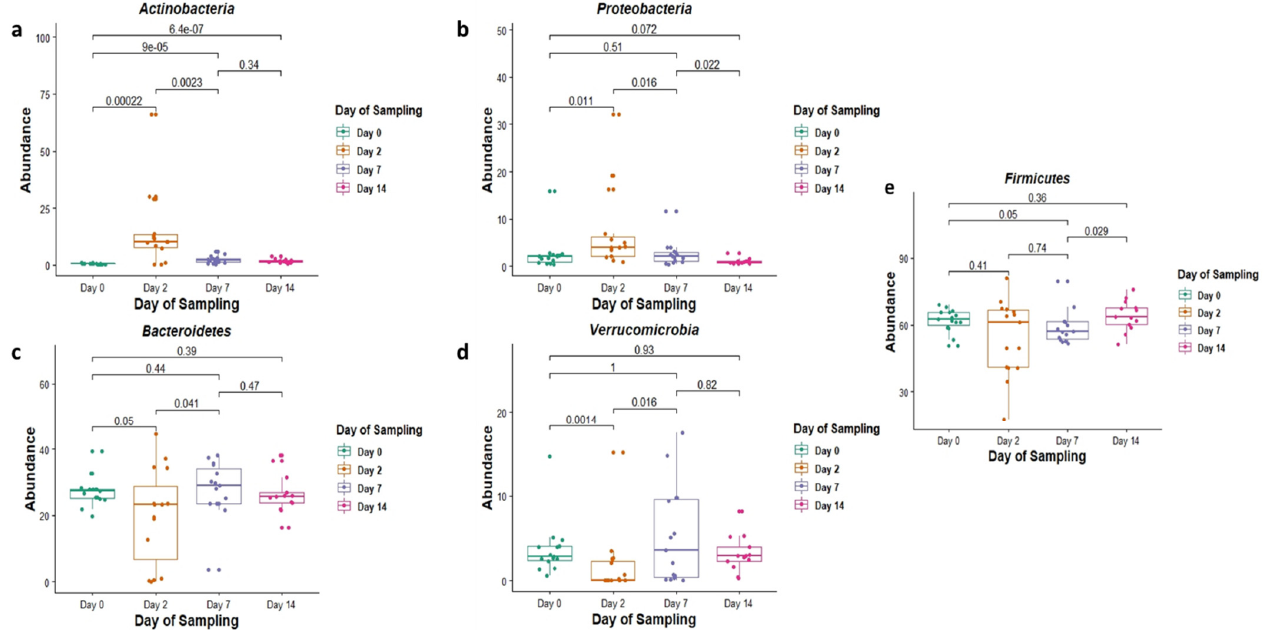
Figure 2. The relative abundance (in %) of the phyla ( a ) Actinobacteria , ( b ) Proteobacteria , ( c ) Bacteri- odetes , ( d ) Verrucomicrobia and ( e ) Firmicutes in faecal DNA on either the day of induction (day 0), or 2, 7 and 14 days post induction (days 2, 7 and 14) .